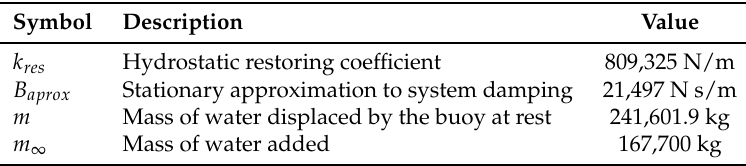
Table 2. Parameters of the models (15) and (16) for the WEC